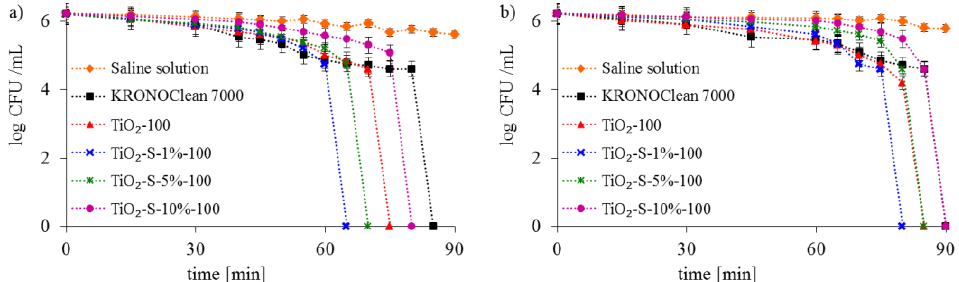
Figure 8. Inactivation of Gram-positive S. epidermidis bacteria in the photocatalyst suspensions: ( a ) under UV-A; ( b ) under ASL irradiation.